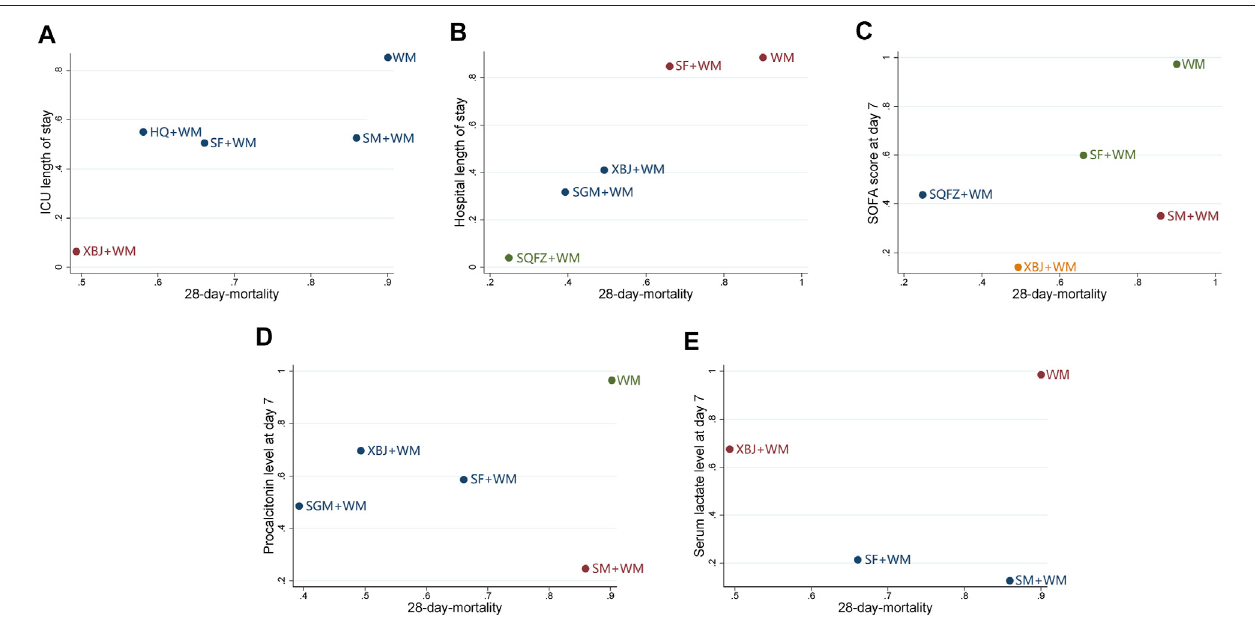
FIGURE5| Clusteranalysisplots (A) 28-days-motality( x -axis)andICUlengthofstay( y -axis) (B) 28-days-motality( x -axis)andhospitallengthofstay( y -axis) (C) 28- days-motality ( x -axis) and SOFA score at day 7 after interventions ( y -axis) (D) 28-days-motality ( x -axis) and procalcitonin level at day 7 after interventions ( y -axis) (E) 28- days-motality ( x -axis) and serum lactate level at day 7 after interventions ( y -axis); WM, Western Medicine; SF, Shenfu injection; SM, Shenmai injection; SGM, Shengmai injection; XBJ, Xuebijing injection; HQ, Huangqi injection; SQFZ, Shenqifuzheng injection. Interventions with the same color belong to the same cluster, and interventions located in the lower-left corner indicate the optimal therapy for two different outcomes while located in the upper-right corner indicate the worst therapy.